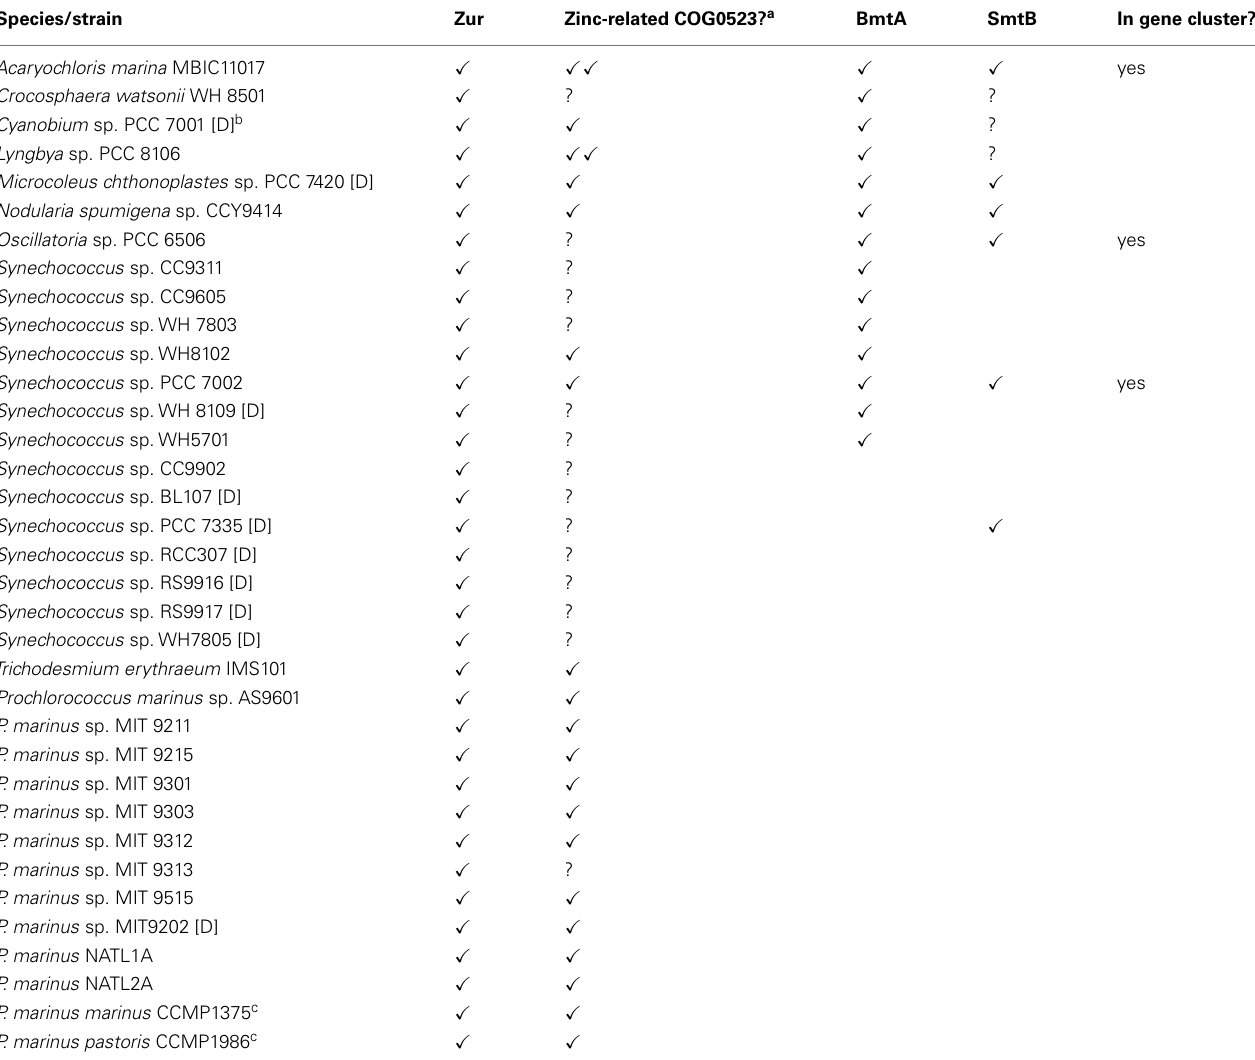
Empty cells indicate absence of a recognizable zinc-related homolog; “?” indicate presence of homologs with unclear metal specificity. a According to analysis of syntenic genome regions or presence of upstream Zur box.